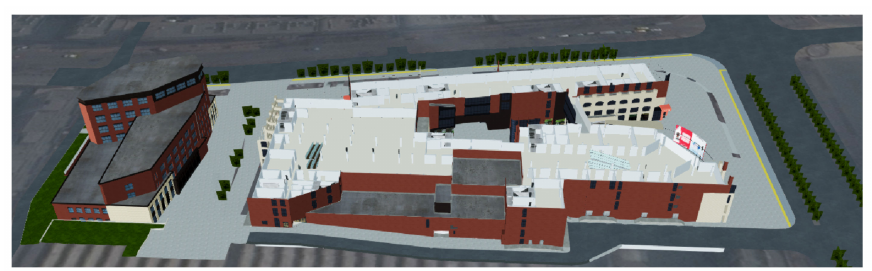
Figure 13. BIM model loads and resolves internal structure.